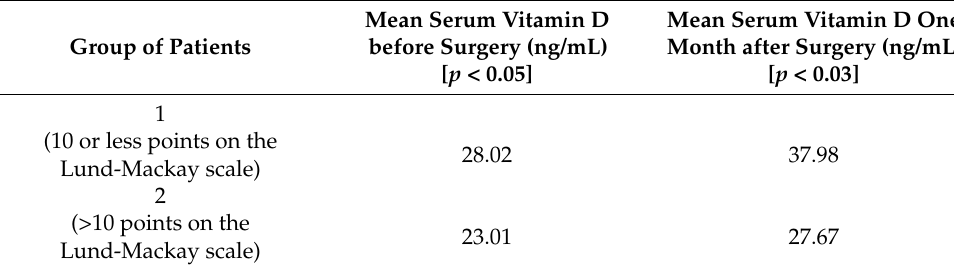
Table 2. Mean serum vitamin D before and one month after surgery (ng/mL) in group 1 and 2.